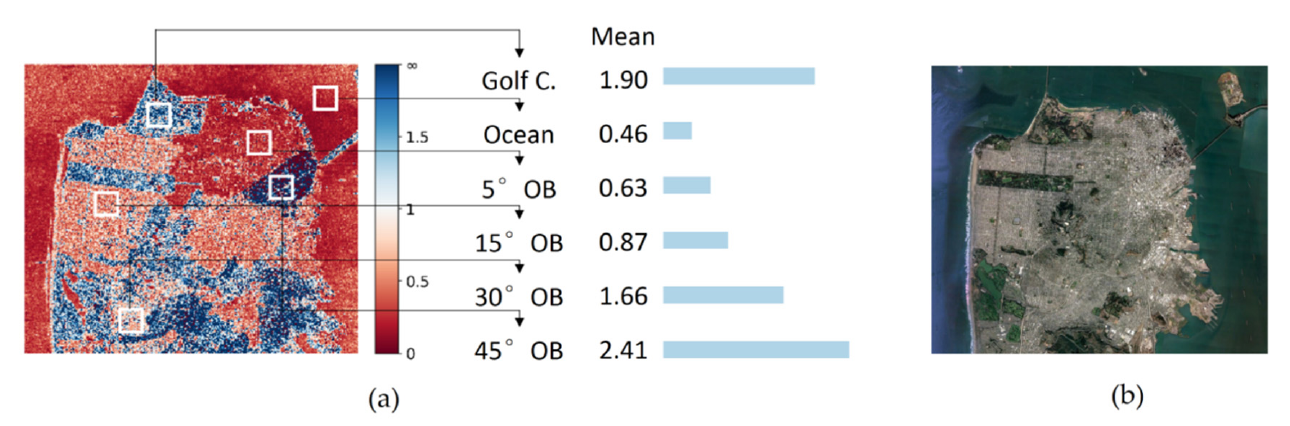
Figure 12. ( a ) The output map of aggregation parameter for ADAM implemented on a RADARSAT-2 C-band image over San Francisco, USA, with the statistical results of γ of different land-use types; ( b ) high resolution satellite image (OB: oriented building).